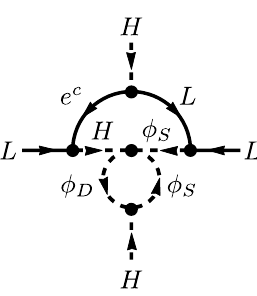
Figure 18 . Two loop diagram which can be built in a model with the scalar (cid:12)elds (cid:30) S (cid:17) ( 1 ; 1 ; (cid:0) 1) and (cid:30) D (cid:17) ( 1 ; 2 ; (cid:0) 3 = 2). Note that because H ( x ) H ( x ) (cid:30) S ( x ) = 0, it is not possible to remove the bottom loop in the